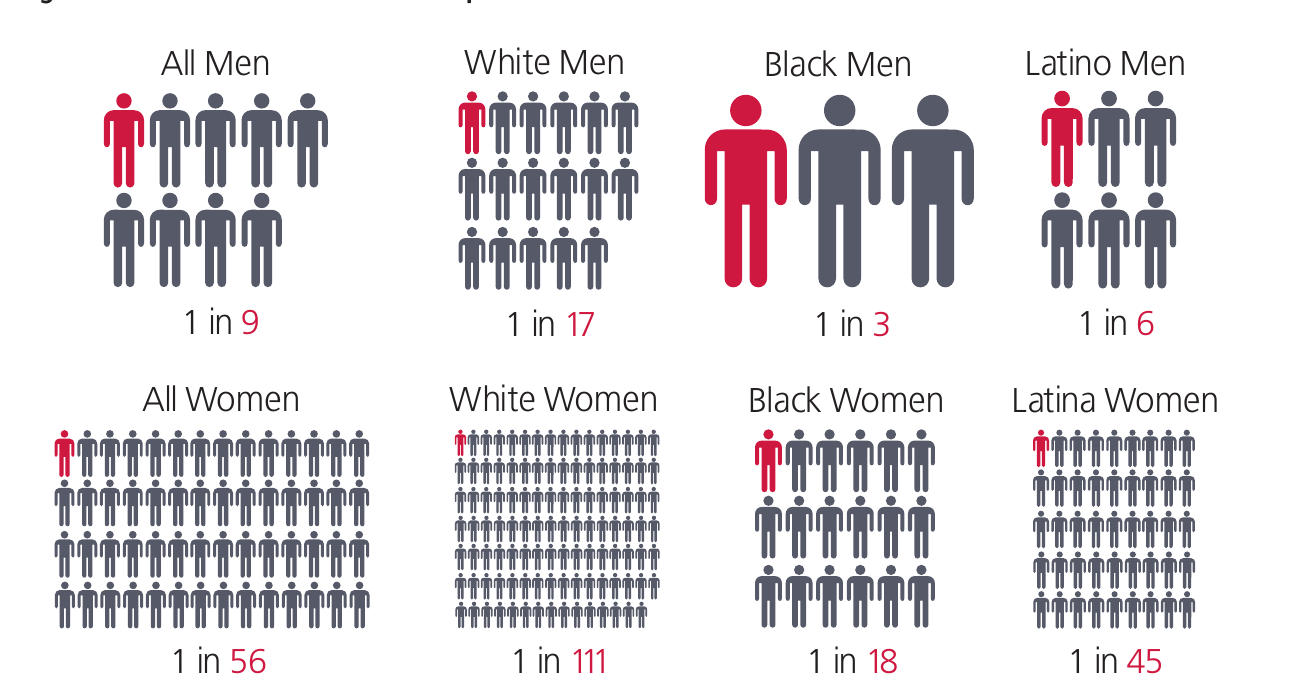
Figure 6. Lifetime likelihood of imprisonment for those born in 2001